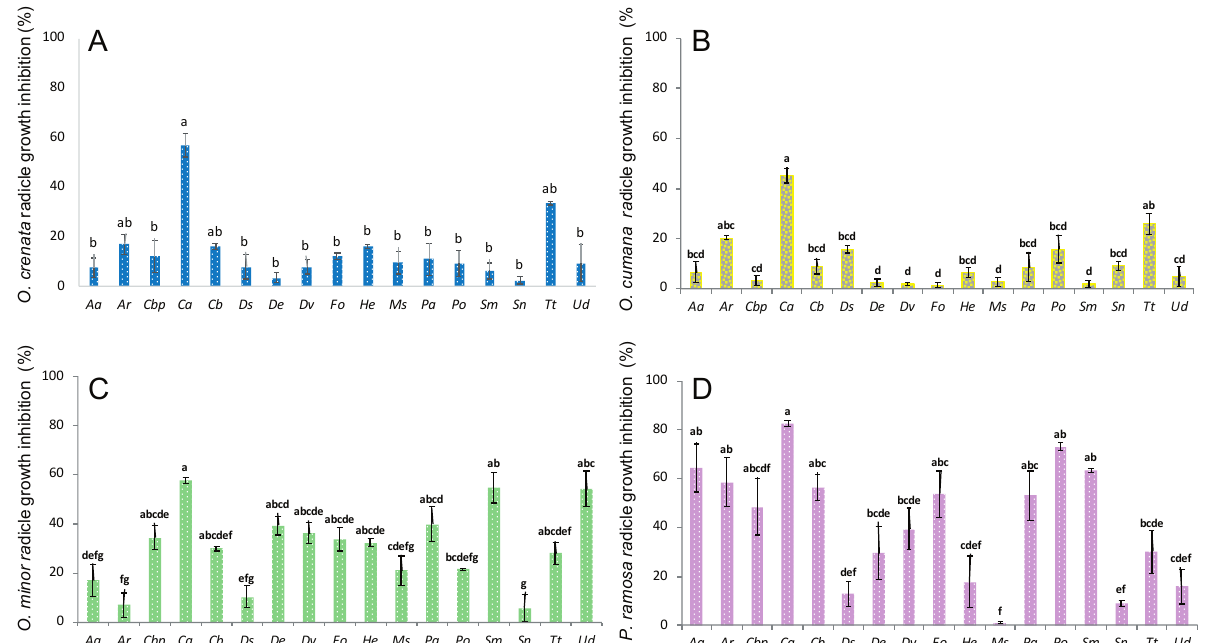
Figure 2. Mean growth inhibition of broomrape radicle growth induced by organic extracts from roots of seventeen weed species, includ- ing: Amaranthus albus L. (Aa); Amaranthus retroflexus L. (Ar); Cbp, Capsella bursa-pastoris (L.) Medik.; Ca, Convolvulus arvensis L.; Cb, Conyza bonariensis L.; Ds, Datura stramonium L.; De, Diplotaxis erucoides (L.) DC.; Dv, Diplotaxis virgate (Cav.) DC.; Fo, Fumaria officinalis L., He, Heliotropium europaeum L.; Ms, Malva sylvestris L.; Pa, Polygonum aviculare L.; Po, Portulaca oleracea L.; Sm, Silybum marianum (L.) Gaertn., Solanum nigrum L.; Tt, Tribulus terrestris Boiss.; Ud, Urtica dioica L.. Extracts were assessed at 100 μg per mL of organic extract (10 -6 M) on radicles of four broomrape species, including: Orobanche crenata Forsk. (A); Orobanche cumana Wallr. (B); Orobanche minor Sm. (C); and Phelipanche ramosa (L.) Pomel (D). Means accompanied by different letters are significantly different according to the LSD test ( P < 0.05). Error bars represent the standard error of the